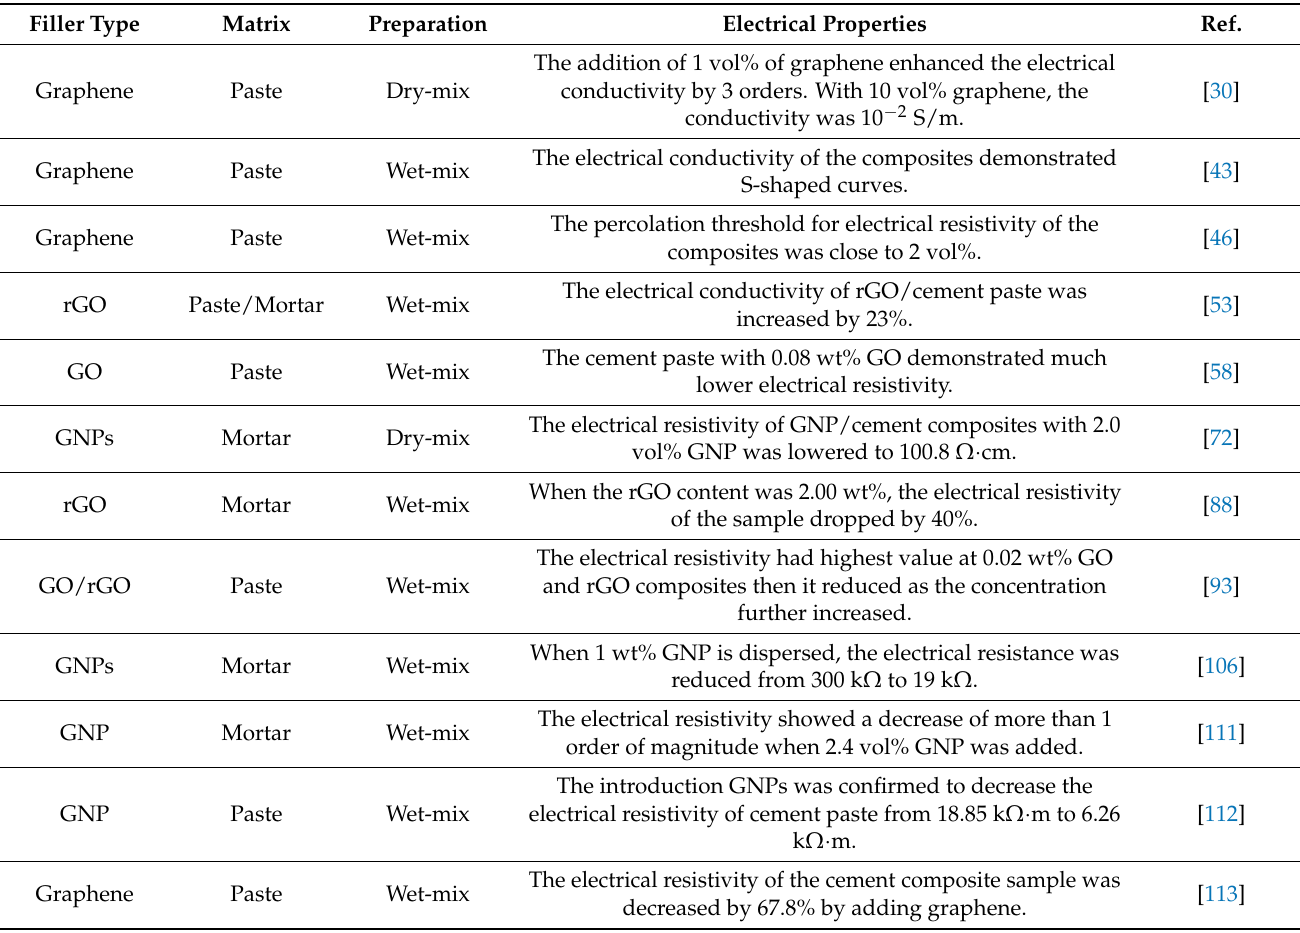
Table 3. Summary of studies on electrical properties of